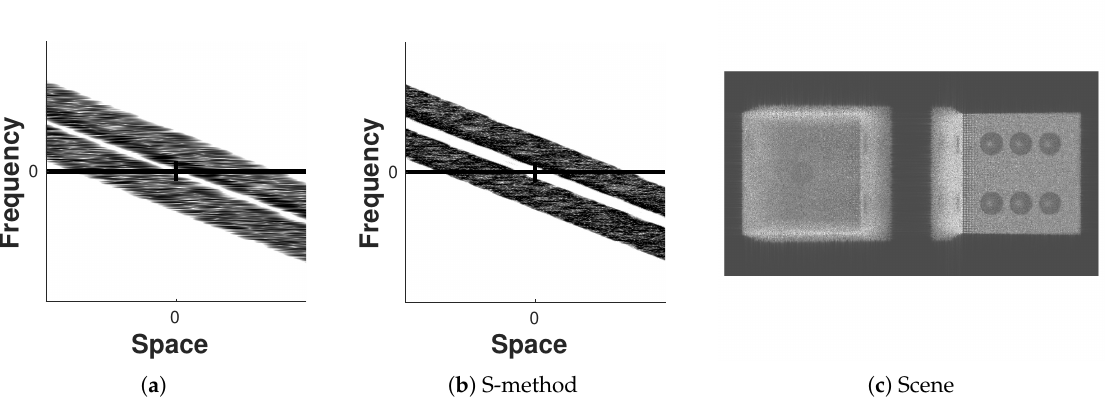
Figure 6. A hologram of 2 dices in close proximity is used to contrast the phase space resolution of the spectrogram and the S-method. A back-propagation of the scene is shown in ( c ). ( a ) Spectrogram; ( b ) S-method; ( c )